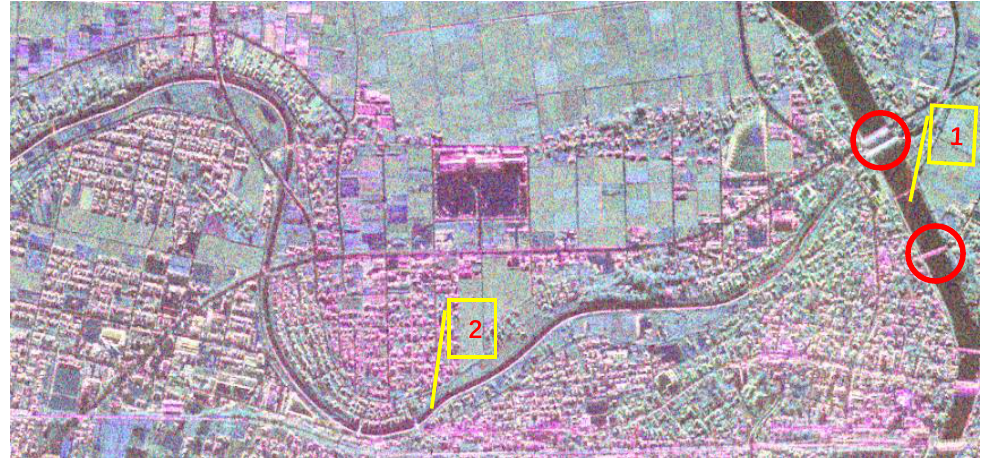
Figure 1. Diagram of bridge distribution in polarimetric SAR images, where some bridges are marked in red circles, the region indicated by yellow box 1 is a high speckle noise region, and the region indicated by yellow box 2 is a complex coastal terrain